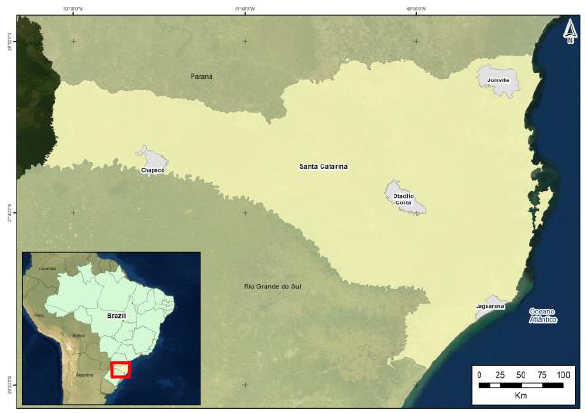
Figure 1 – Map of the Study